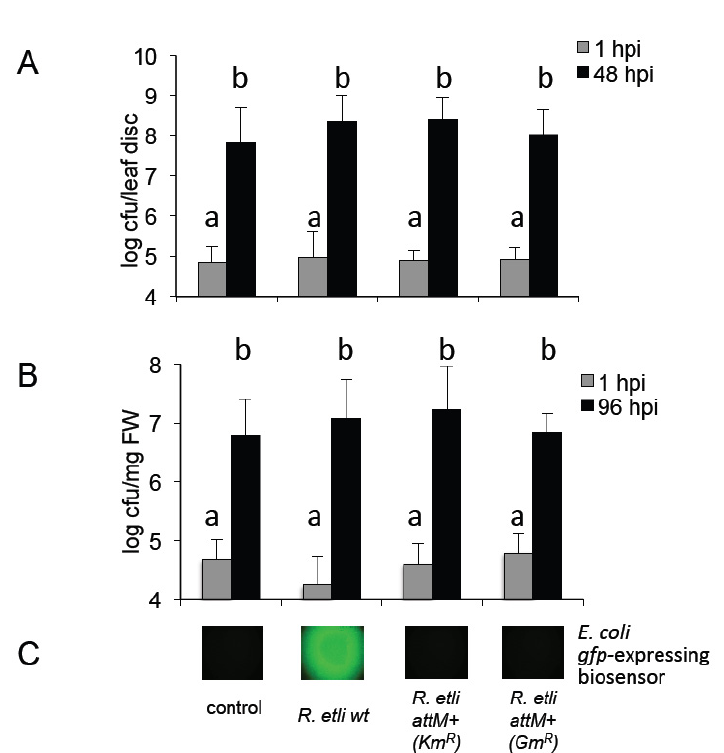
Figure S3. R. etli strains have no impact on Arabidopsis resistance towards P. syringae bacteria. Proliferation of the plant pathogenic P. syringae DC3000 ( Pst ) on plants pretreated with MgCl (control) or different R. etli strains, producing different quantities of 2 oxo-C8-HSL. ( A ) Pst bacteria were infiltrated into Arabidopsis leaves. OD ( B ) Arabidopsis plants were spray-inoculated with Pst bacterial solution, OD ( C ) AHL production in R. etli strains used in the above experiments detected by the bacterial biosensor strain of E. coli . Student’s t -test revealed no differences between the treatments at p ≥ 0.05, as indicated by the letters in ( A ) and ( B ).